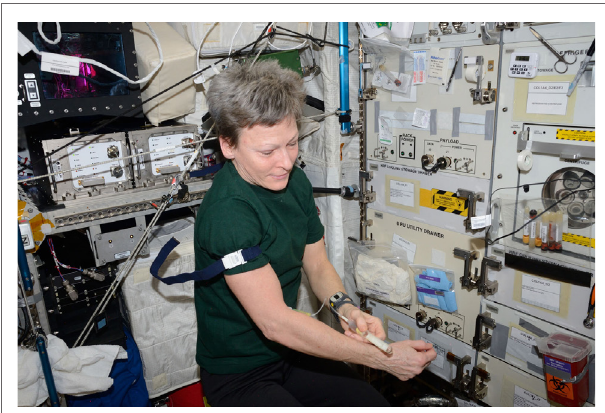
FiguRe 2 | NASA Astronaut Peggy Whitson collects a blood sample in the European Space Agency “Columbus” module onboard the International Space Station. The blood sample was for the study of the immune system of astronauts. The blood samples were transported, ambient temperature to preserve cell viability, to Earth for terrestrial analysis. The individual depicted has provided written consent for the publication of this image. To maintain viability, samples were collected during spaceflight in ACD anticoagulated tubes. The average delay from collection onboard ISS, through landing, to terrestrial analysis in Houston, Texas was ~37